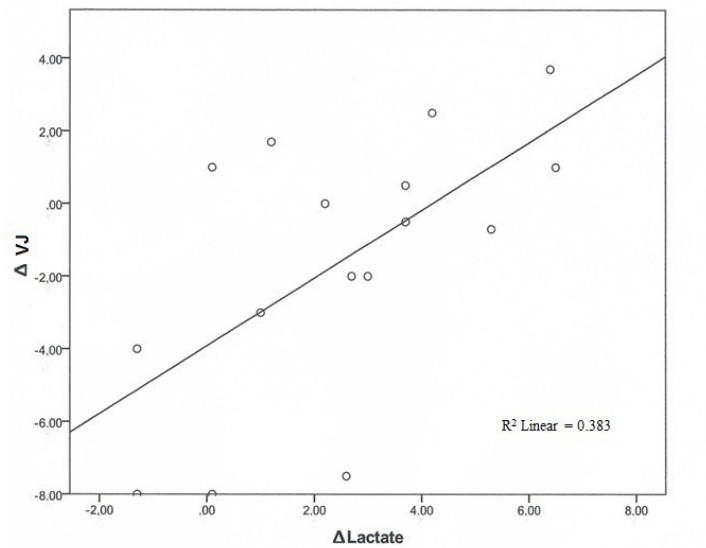
Figure 1. Regression showing the increase in lactic acid and VJ from the first to the last sets. VJ: countermovement